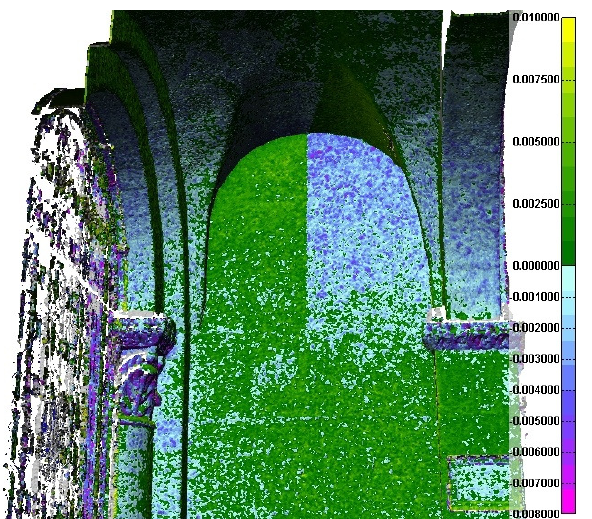
Figure 12. Error map for subproject 7 showing a turning-break